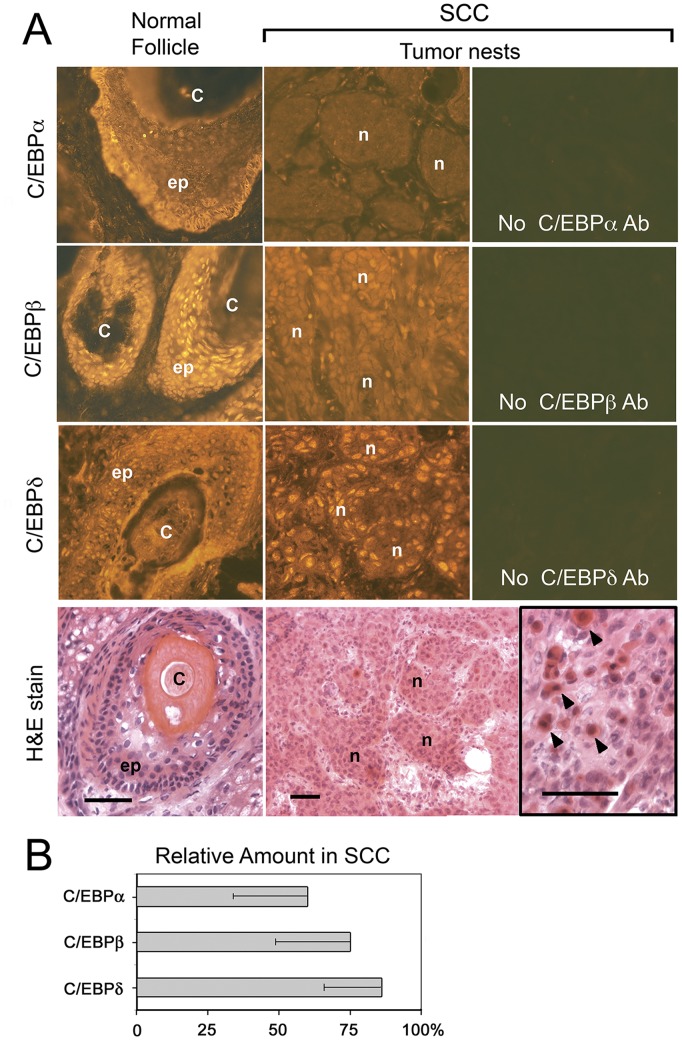
Expression patterns of C/EBPα, C/EBPβ, and C/EBPδ in human squamous cell carcinoma (SCC).(A) Frozen skin sections from patients with SCC were fluorescently immunostained, using antibodies to C/EBPα, C/EBPβ, or C/EBPδ (as indicated on left) followed by a Cy3-fluorotagged anti-IgG secondary antibody. Hematoxylin and eosin (H&E) stains were done on parallel sections. Tumor nests (n), and normal hair follicle epithelium (ep) and cortex (C), are indicated. Inset: Arrowheads indicate well-differentiated squamous cells, expressing high levels of keratins (red). Scale bars, 50 µm. (B) Quantification of fluorescent staining intensities for the three C/EBP family proteins (α,β and δ) in eleven SCC tumors, relative to normal follicles; mean ± SD.